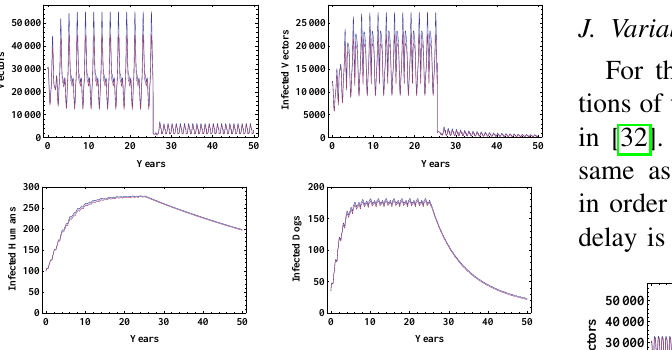
Fig. 7. Case (vi): Model behavior with variability in τ 1 .